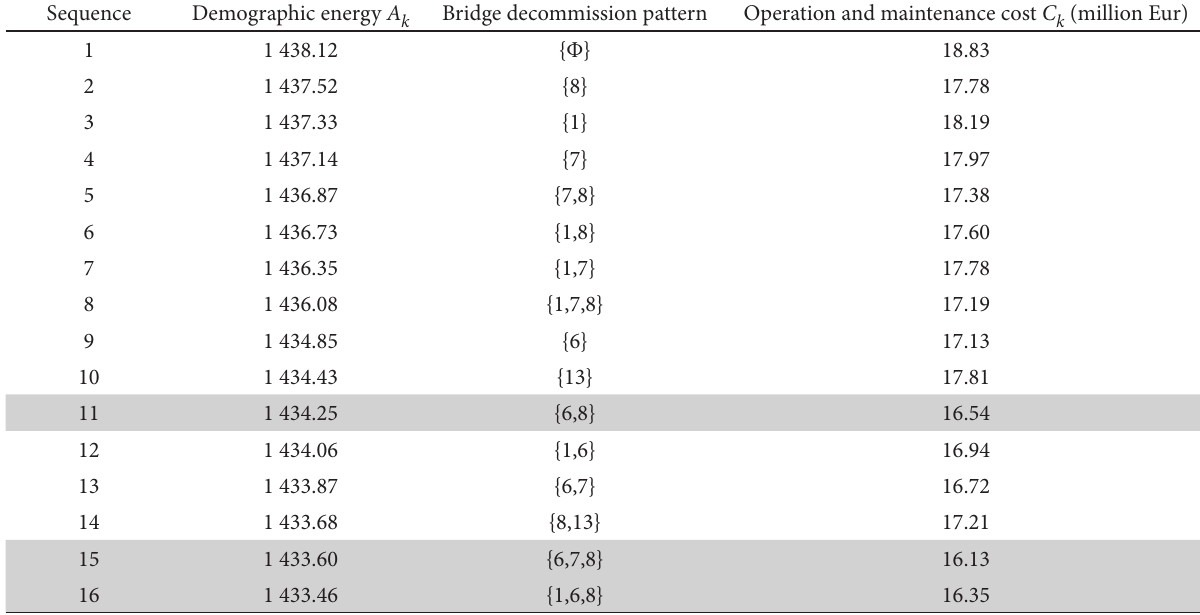
Table 7. Sequence of demographic energy A k (Radial network, Scenario 1, Top 16) Sequence